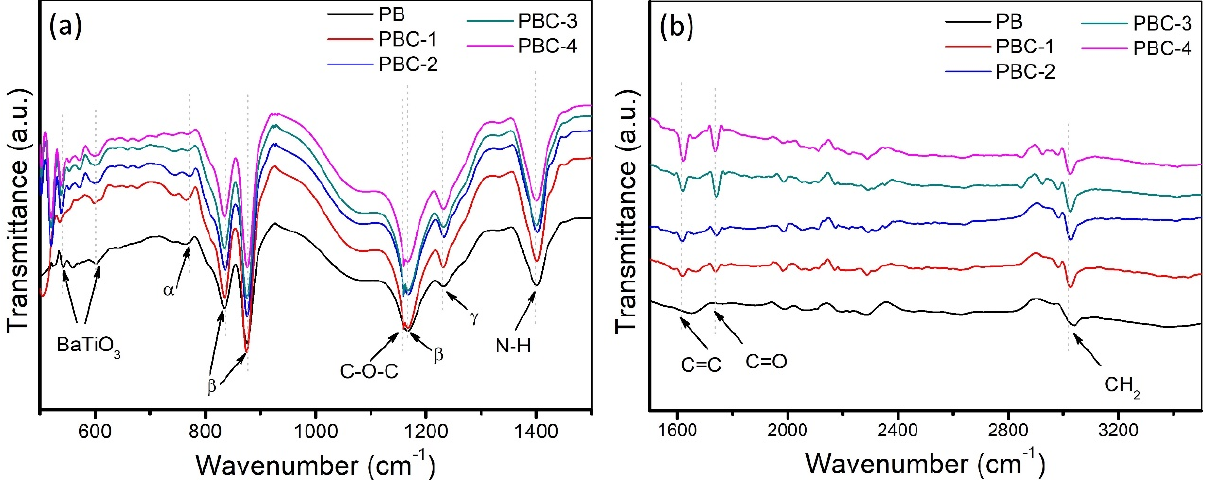
Figure 5. FTIR results for the as ‐ prepared PVDF–BaTiO 3 (PB) and PVDF–BaTiO3 ‐ xCNT (PBC) films within ( a ) 500–1500 cm − 1 and ( b ) 1500–3500 cm − 1 wavenumber range.